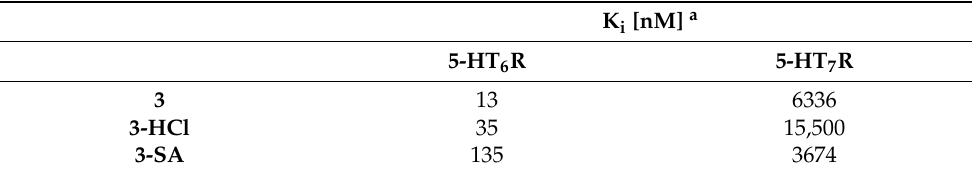
Table 5. Affinity results for the serotonin 5-HT 6 and 5-HT 7 receptors of salts of compound 3 .